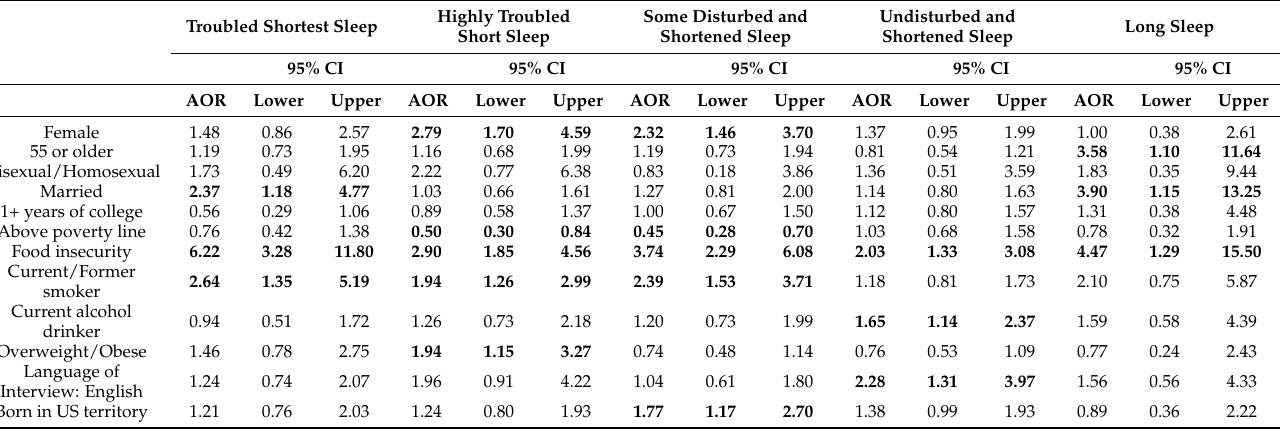
Table 4. Multinomial logistic regression of covariates on six-class solution using Class 5 or nor- mal/average sleep profile as reference (N =